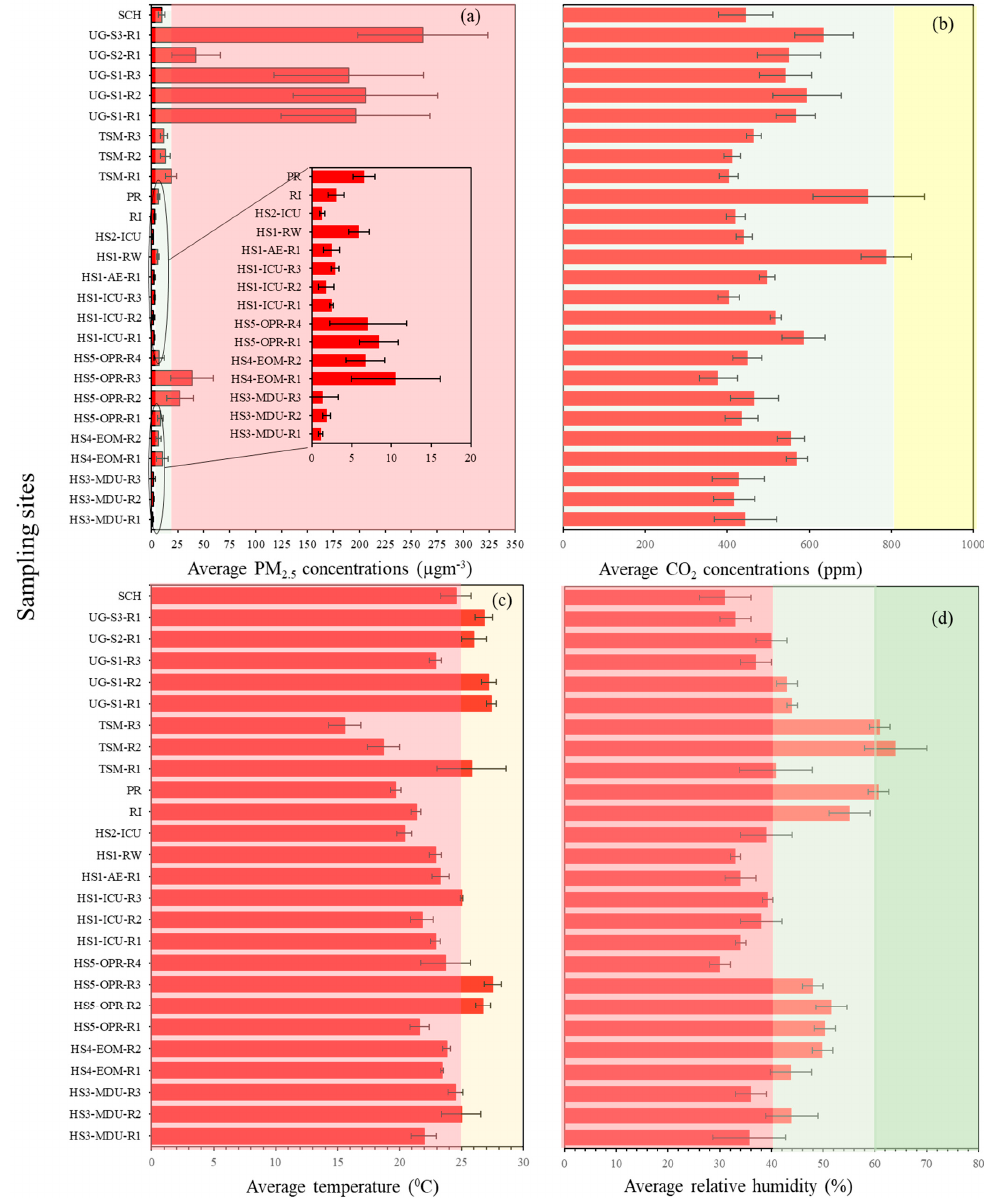
Figure 2. ( a ) Mean PM 2.5 concentrations at all sampling sites. The green shaded part shows the DEFRA UK standard acceptable levels for 24 h average exposure to 15 μ g m − 3 for PM 2.5 concentra- tions. ( b ) Mean CO 2 concentrations at all the sampling sites. ( c ) Mean temperature recorded at all the sampling sites. The red shaded section highlights temperatures from 0 ◦ C to 25 ◦ C where virus viability is optimal, the yellow shaded area highlights the temperature range >25 ◦ C to 30 ◦ C where virus viability is moderate, and >30 ◦ C (not included in the graph) is the temperature range with low virus viability. ( d ) Mean average concentrations of RH for all sampling sites. The red shaded part highlights a RH < 40% resulting in higher virus transmission risk, the pale green shaded part highlights RH of 40% to 60%, reduced transmission risk conditions, the green shaded part shows RH at 60%, which represents a potentially lower virus transmission risk, and the red shaded part with RH 0% to 40% highlights the range with increased virus transmission